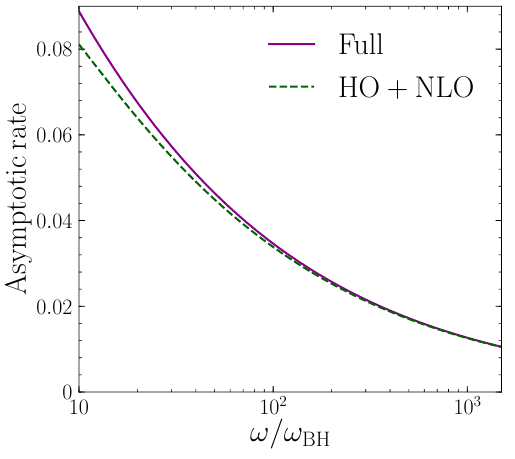
Figure 6 . Asymptotic rates for the all-order evaluation (magenta solid lines) and the HO+NLO (green dashed) approximation as a function of ˆ x = ω/ω BH